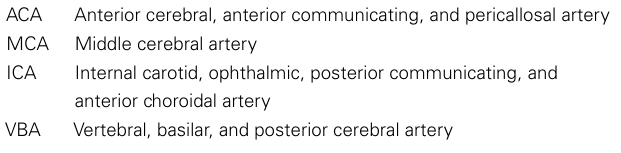
Table 1 | Koivisto categories for grouping aneurysm locations Location of unruptured and ruptured aneurysms in males and